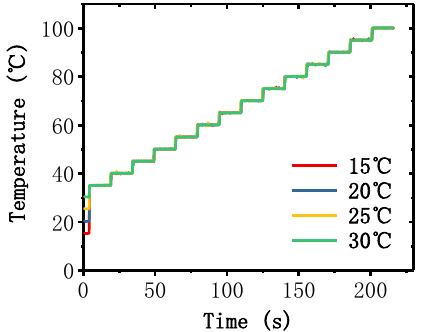
Figure 9. Temperature traces of the PCR thermal control chip under different environmental temperatures (15, 20, 25, and 30 °C) measured by RTDs. The heating rate in the lower temperature range was much higher than the average heating rate, and the time consumption of heating to the start point (35 °C) was negligible; hence, the temperature traces from the environmental temperature to the start point (35 °C) were approximately coincident.